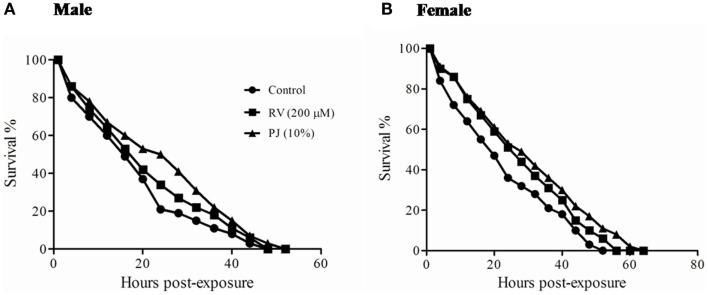
Survival against superoxide radical (O*) produced by paraquat exposure in 20 days old Drosophila. (A) PJ (10%) group showed 54% increase in median survival (p < 0.00001) while RV (200 μM) could increase only by 9.6% (Table 1). (B) Female flies fed with PJ showed 45.9% increase in median survival (p < 0.00001) while RV was able to increase the median survival by 32.4%.